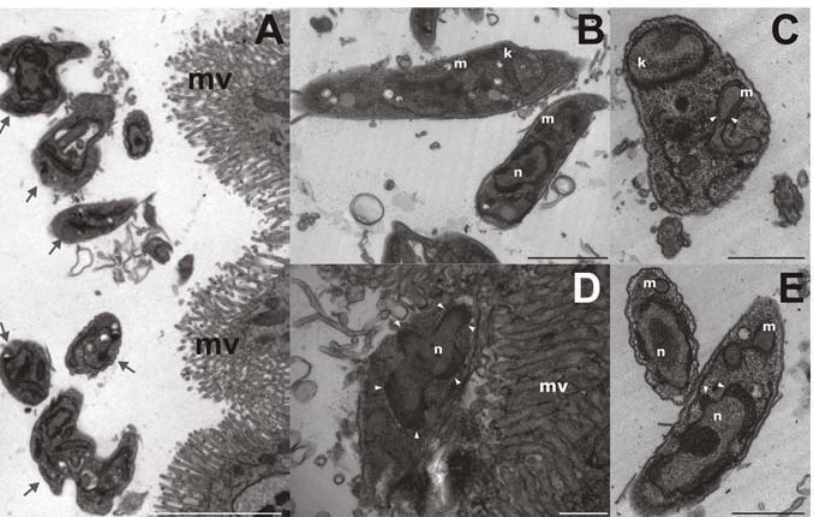
Figure 6. Ultrastructural analysis of metacyclic promastigotes within infected sand flies. Lutzomyia longipalpis sand flies were fed with heparinized mice blood containing infected macrophages. After 10 days female insects were pooled and guts were harvested and fixed for transmission electron microscopy. ( A ) Morphological heterogeneity of promastigotes in the intestinal lumen of a sand fly, displaying normal nucleai, kinetoplasts and mitochondria. ( B ) As in A with a higher magnification. ( C ) Promastigote showing intense mitochondrial swelling (white arrowheads) and loss of kinetoplast organization in addition to vacuole-like structures, formed by mitochondrial or endoplasmic-reticulum membranes containing cytoplasmic material. ( D ) Promastigote attached to intestinal microvilli showing highly condensed chromatin clumped to protrusions in nuclear lobes (white arrowheads). ( E ) Promastigotes with condensed chromatin and mitochondrial membrane expansions eventually containing cytoplasmic material. Bars represent 1 m m; m, mitochondrion; k, kinetoplast; n, nucleus; mv, microvili.